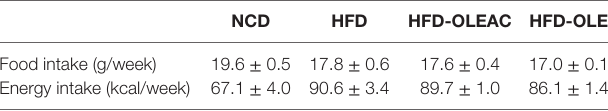
Values are expressed as mean ± SD. HFD, HFD-OLEAC, and HFD-OLE indicate mice fed with HFD, or HFD and oleacein or oleuropein, respectively. NCD indicates the animals fed with normocaloric